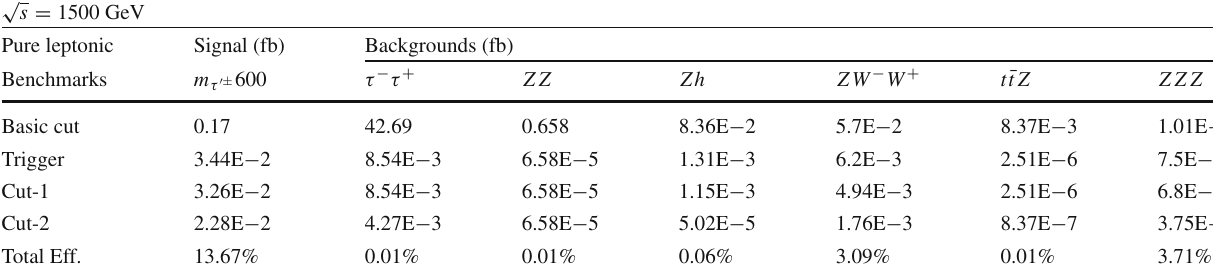
Cut-1 Total Eff. Table 6 Cut flows of the signal and backgrounds at m τ (cid:2)± = 600 GeV, √ s = 1500 GeV Pure leptonic Signal (fb) Backgrounds